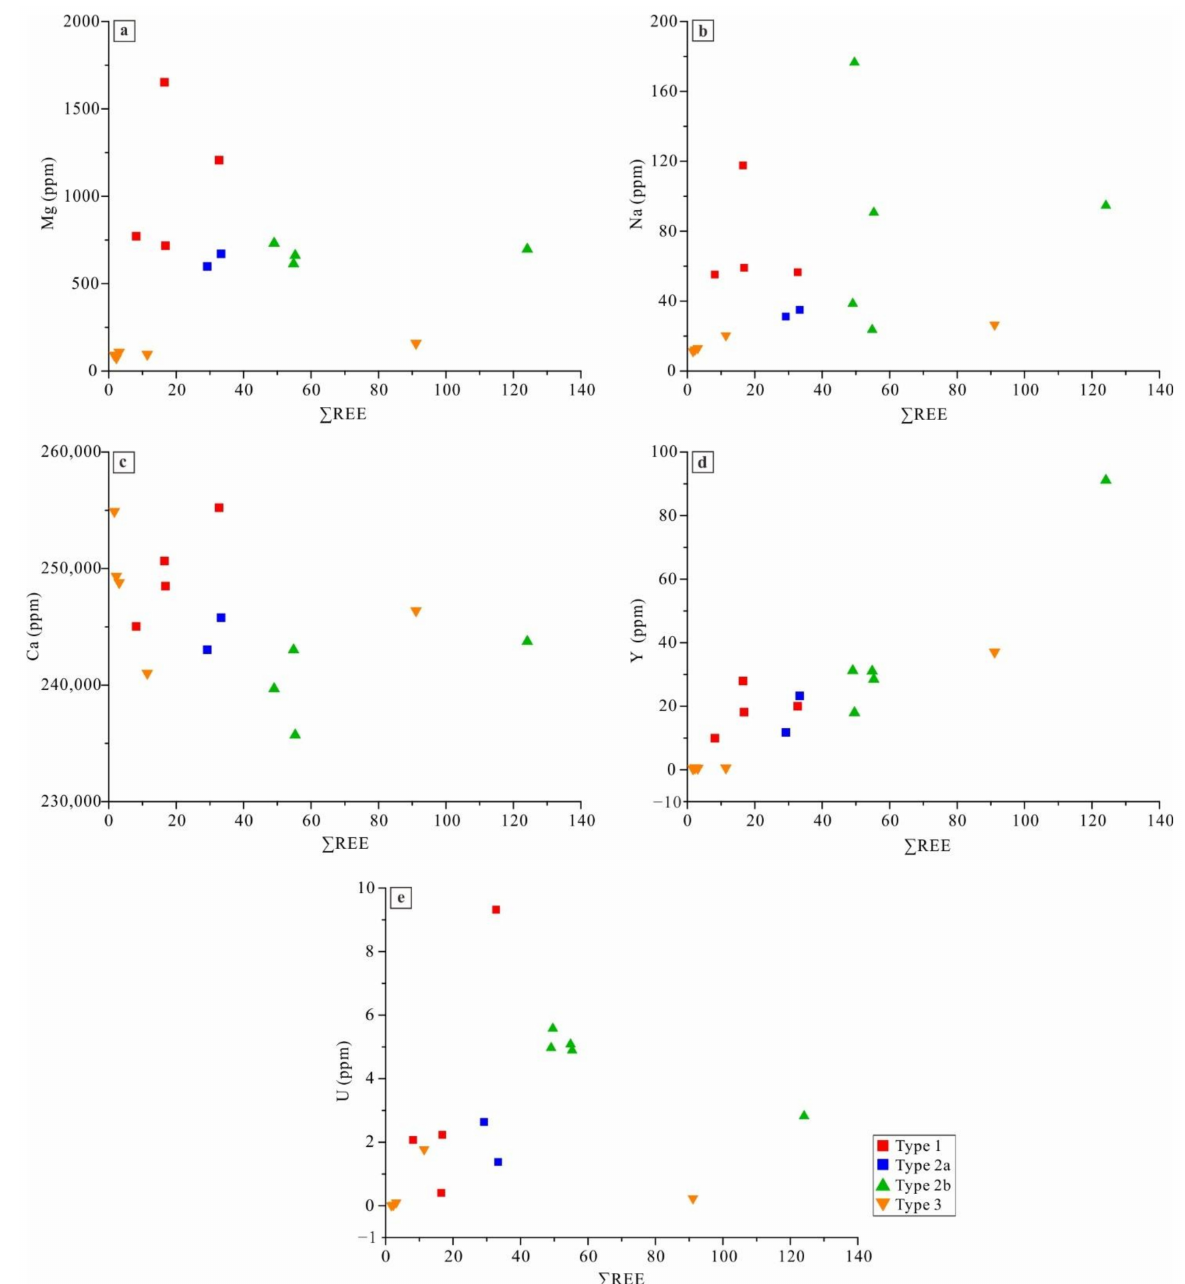
Figure 13. Plots of ∑ REE 3+ with ( a ) Mg, ( b ) Na, ( c ) Ca, ( d ) Y, and ( e ) U (ppm) for garnets in the Laoshankou